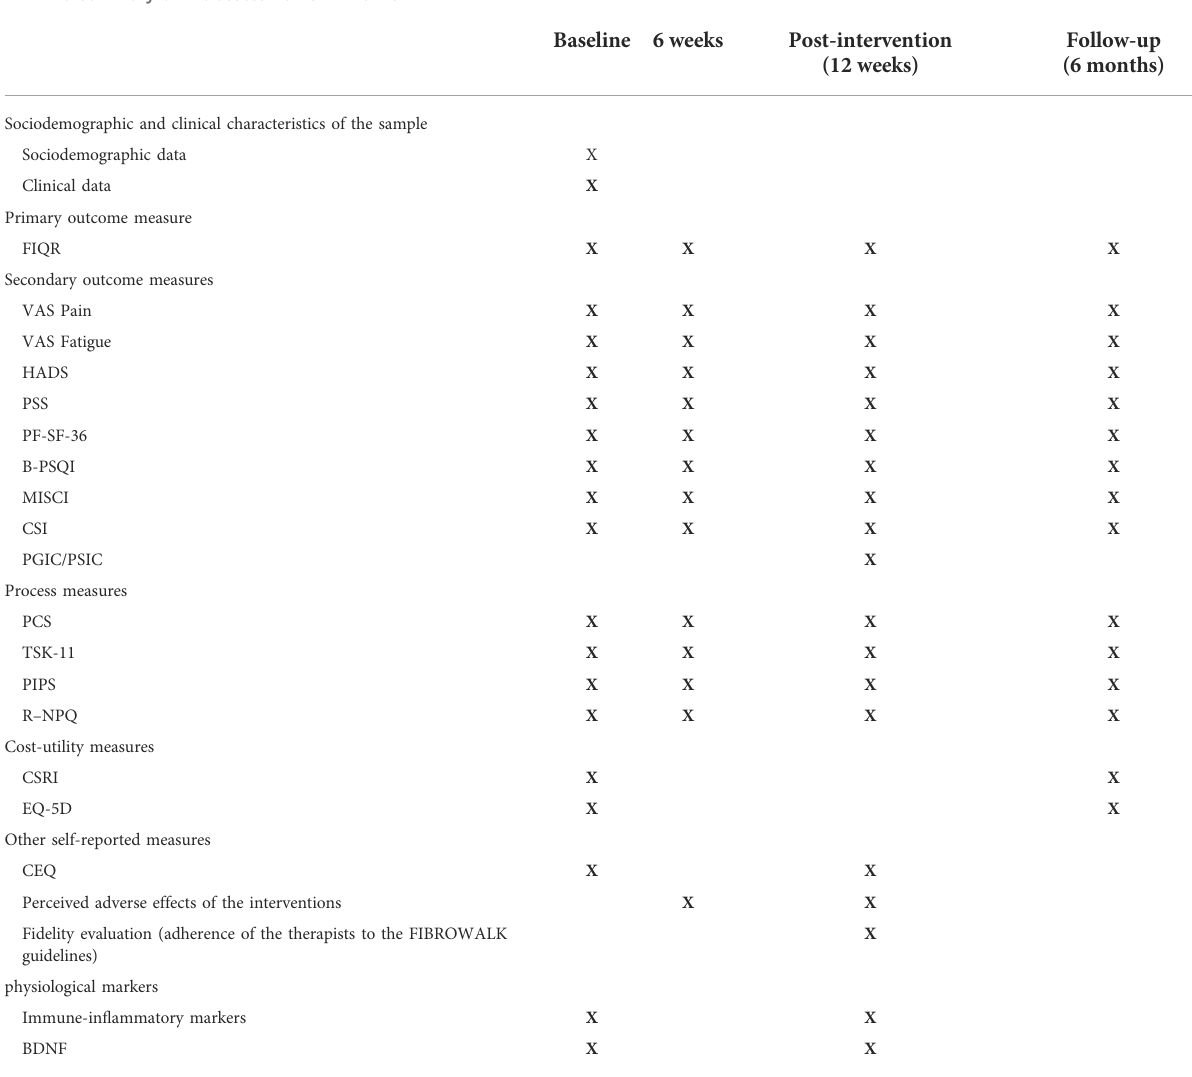
TABLE 3 Summary of the assessments in the